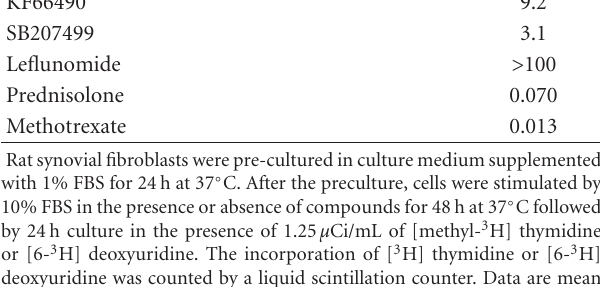
Table 4: IC 50 values of various drugs on serum-induced prolifera- tion of rat synovial fibroblasts.